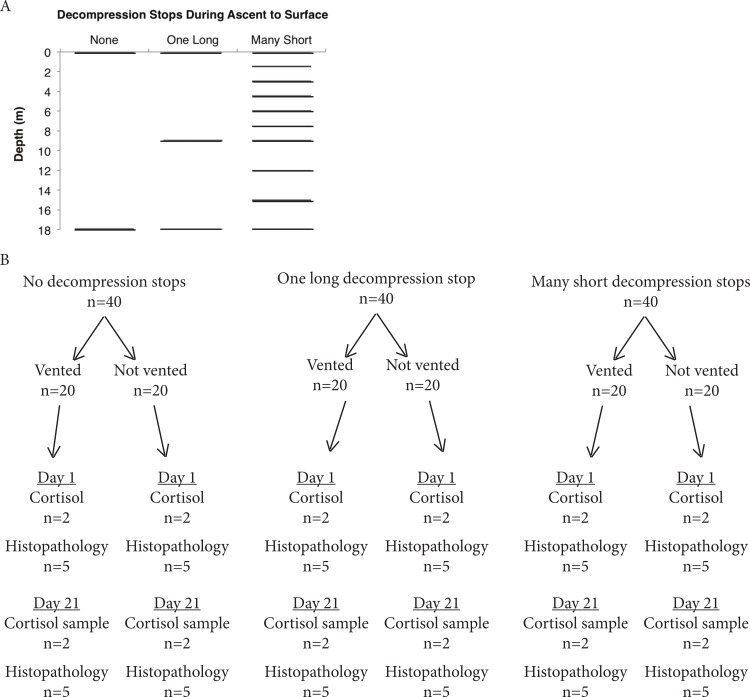
Experimental design of ascent and venting treatments.(A) Illustrates decompression stops for each ascent treatment. The rate of ascent between stops was 0.25 m/s for all treatments. Fish subjected to ascent without decompression stops were brought directly to the surface. Fish subjected to ascent with one decompression stop were brought to half the maximum depth for a 45 min decompression stop, then brought to the surface. Fish subjected to multiple decompression stops were brought up 3 m every 15 min. At 10 m (2 atm), these fish were brought up 1.5 m every 15 min. (B) Venting treatment scheme and fish sampling design. This experiment was replicated 3 times for a total sample size of n = 360 fish.